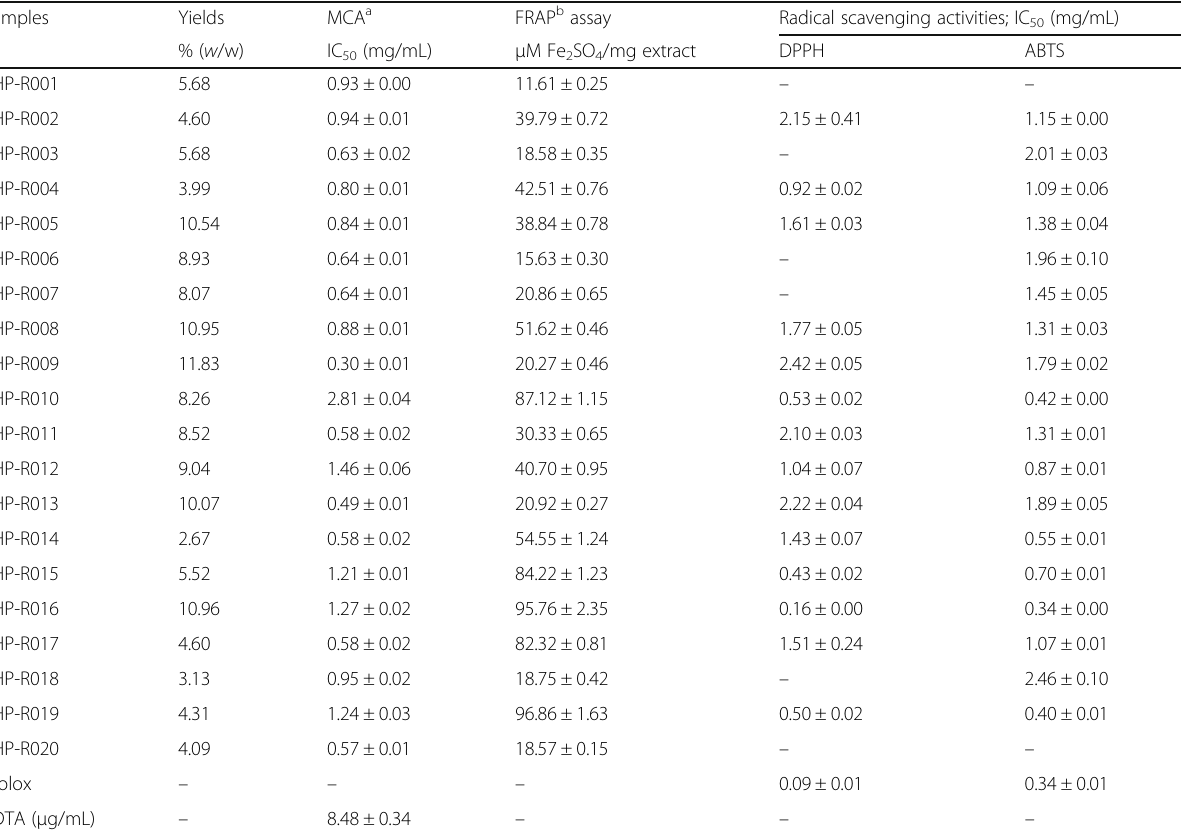
Table 3 Extraction yields and antioxidant capacities of polyherbal formulas Samples